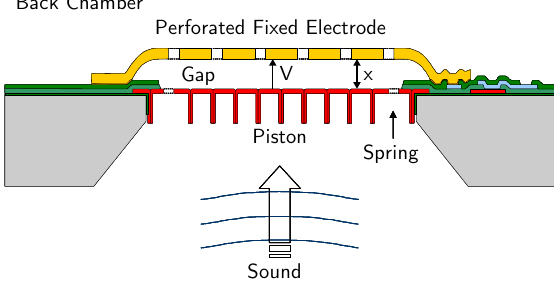
Figure 2. Basic structure and working principle of a MEMS